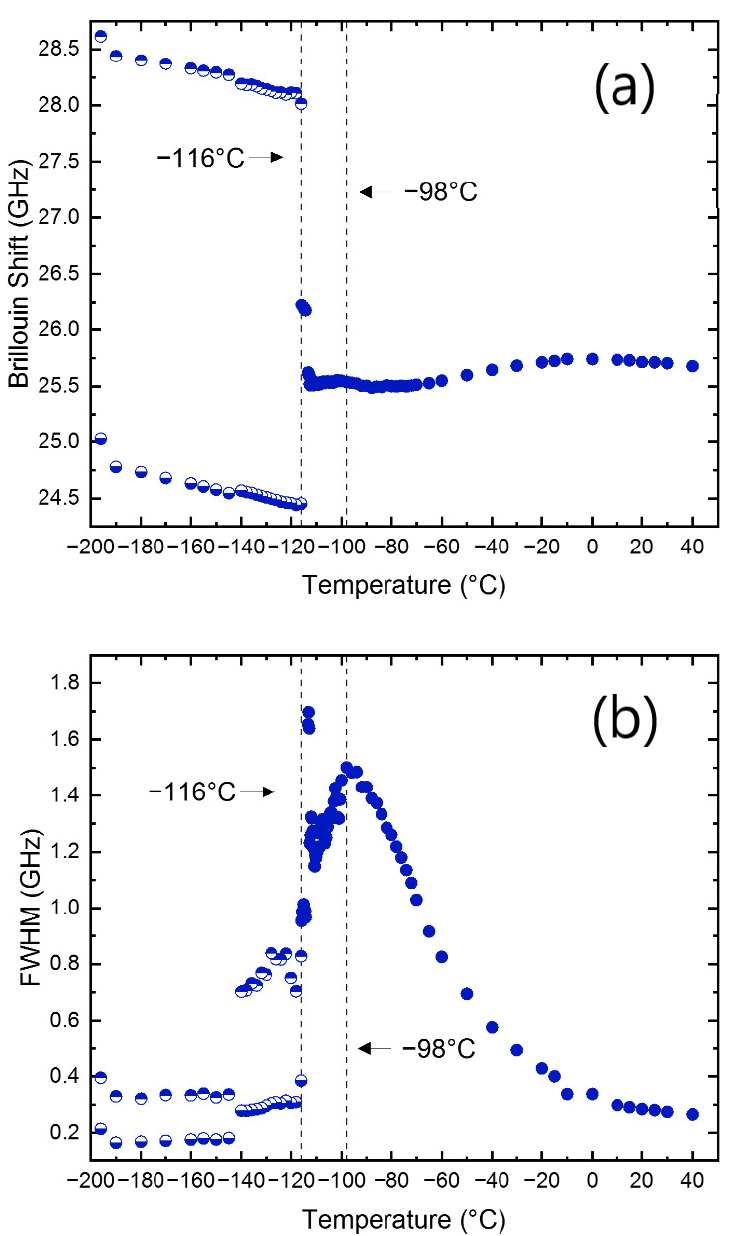
Figure 3. (Color online). Temperature dependences of ( a ) the Brillouin frequency shift and ( b ) the FWHM of the LA mode propagating along the [100] direction, measured upon cooling. The half-filled circles represent the split peaks. The two symbols at low temperatures indicate the data from the split LA mode.